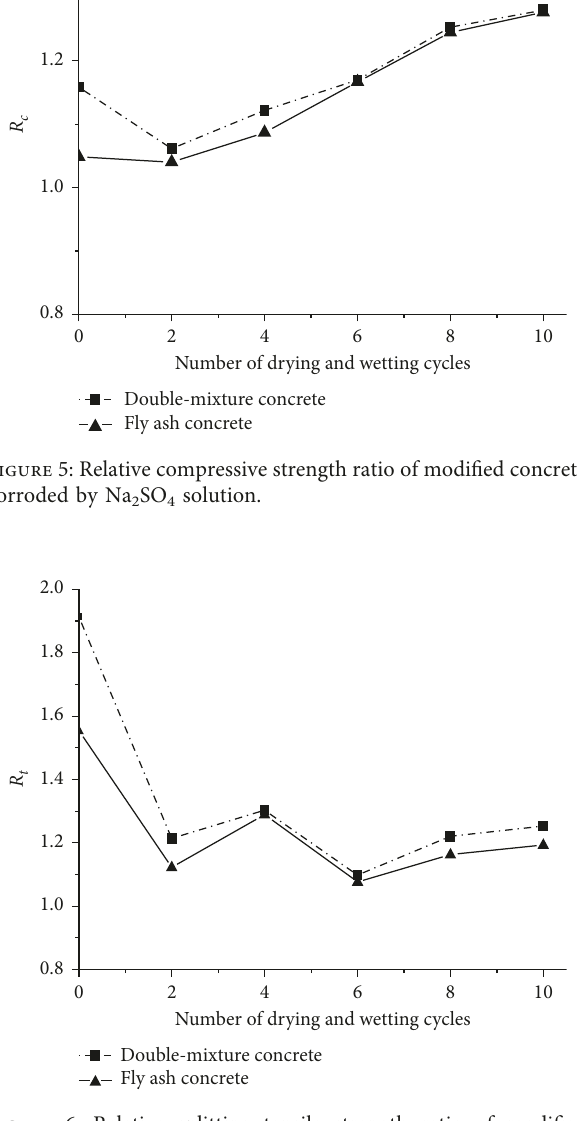
Figure 6: Relative splitting tensile strength ratio of modified concrete corroded by Na 2 SO 4 solution.